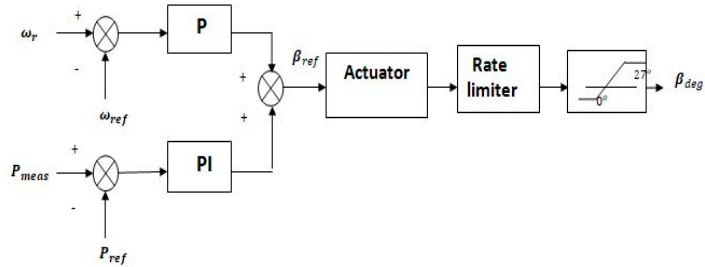
Figure 2. Conventional pitch angle control model for DFIG − based WTS.